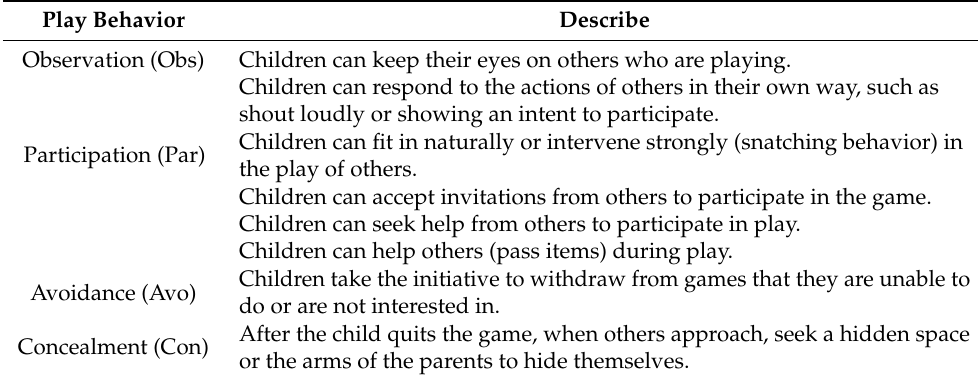
Table 3. General steps for play behavior in children with ASD.